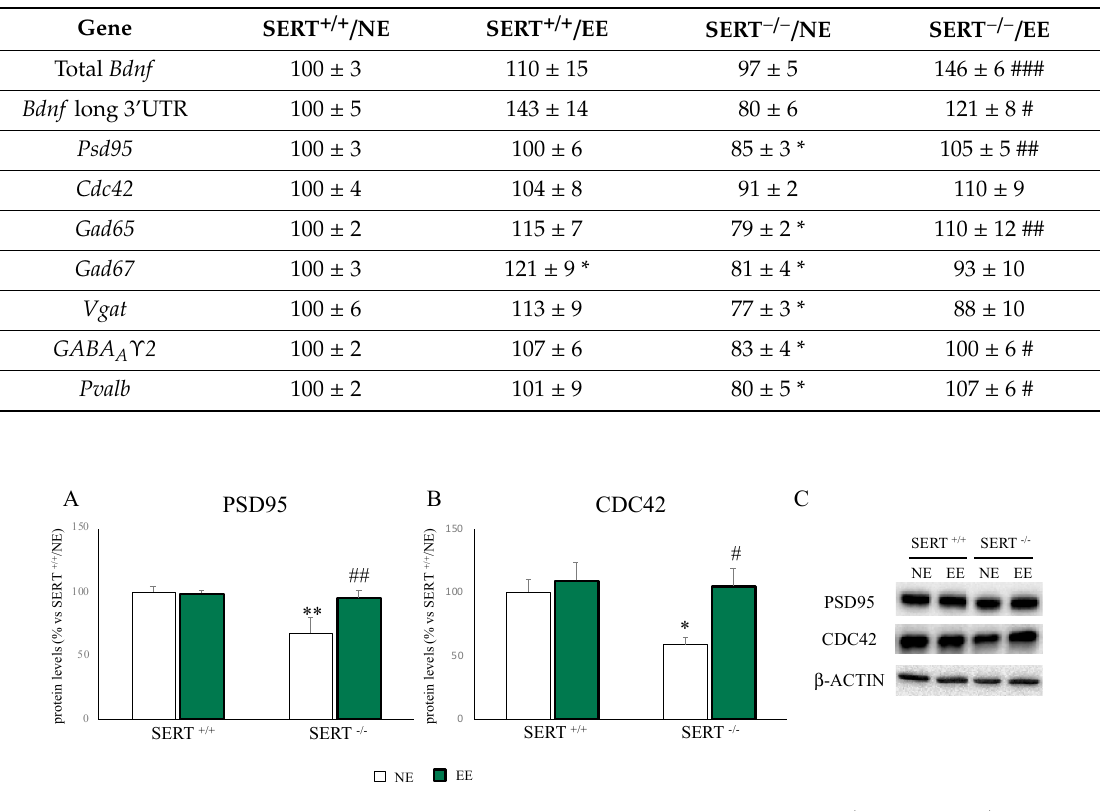
Figure 4. Analyses of PSD95 ( A ) and CDC42 ( B ) protein levels in PFC of SERT +/+ and SERT − / − rats subjected to one month of exposure to NE (normal environment) or EE (environmental enrichment) and their representative western blot bands ( C ). The data are presented as percent change of SERT +/+ / NE and are expressed as mean ± standard error of the mean (SEM). * p < 0.05, ** p < 0.01 vs. SERT +/+ /